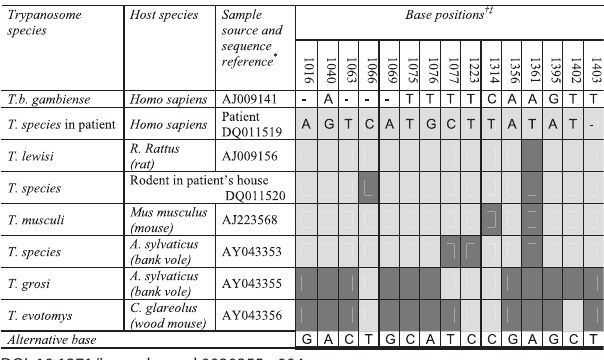
DOI: 10.1371/journal.pmed.0030355.g004 Figure 4. Genotypes of the Parasite Isolated from the Patient, the Parasite Isolated from a Rodent Captured in the Patient’s Home, T. (Herpetosoma) Species and T. b. gambiense at Positions on the 18S Ribosome that Are Polymorphic within the Subgenus T. (Herpetosoma) *, alphanumeric codes represent GenBank numbers for reference samples. † , numbers of base positions are relative to the T. lewisi reference sequence AJ009156. ‡ , the base at all positions is recorded for T. b. gambiense and the patient’s parasite, while the base in other strains is indicated by light shading where it is identical to the base of the patient’s parasite and by dark shading where it matches the alternative